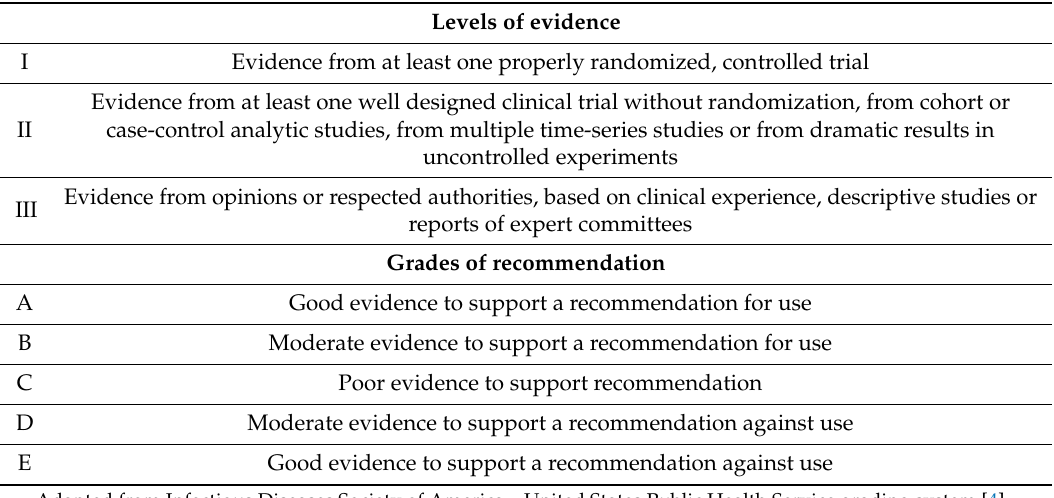
Table 1. Levels of evidence and grades of